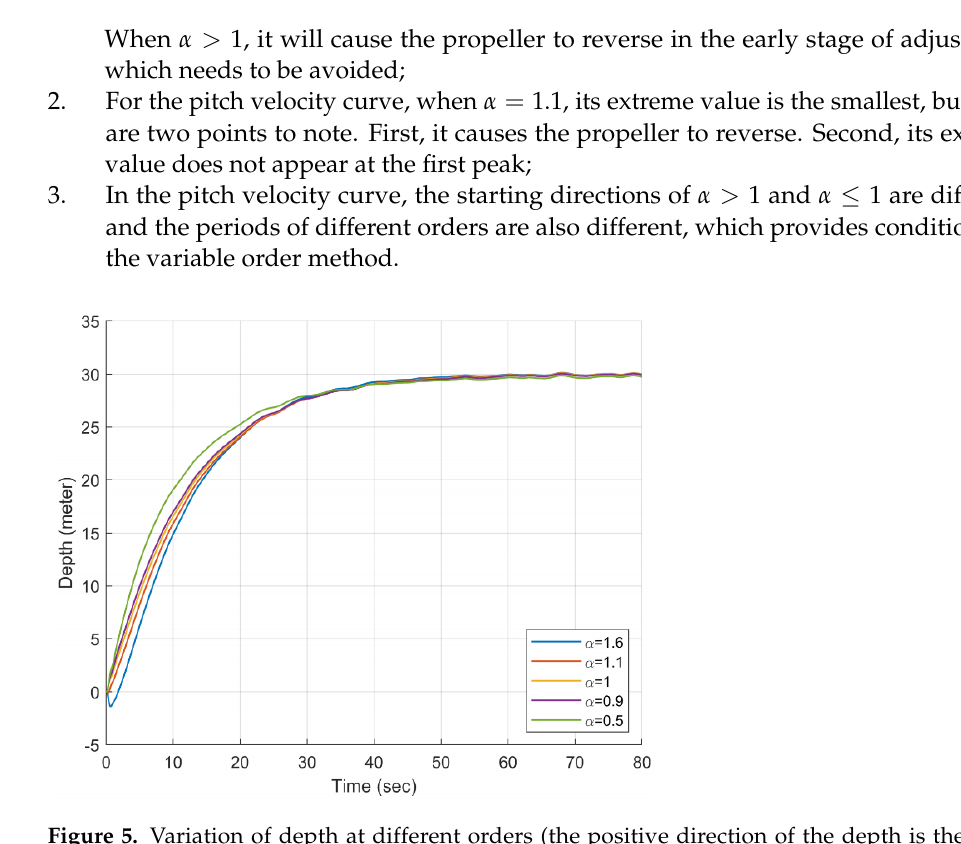
Figure 5. Variation of depth at different orders (the positive direction of the depth is the water surface down).